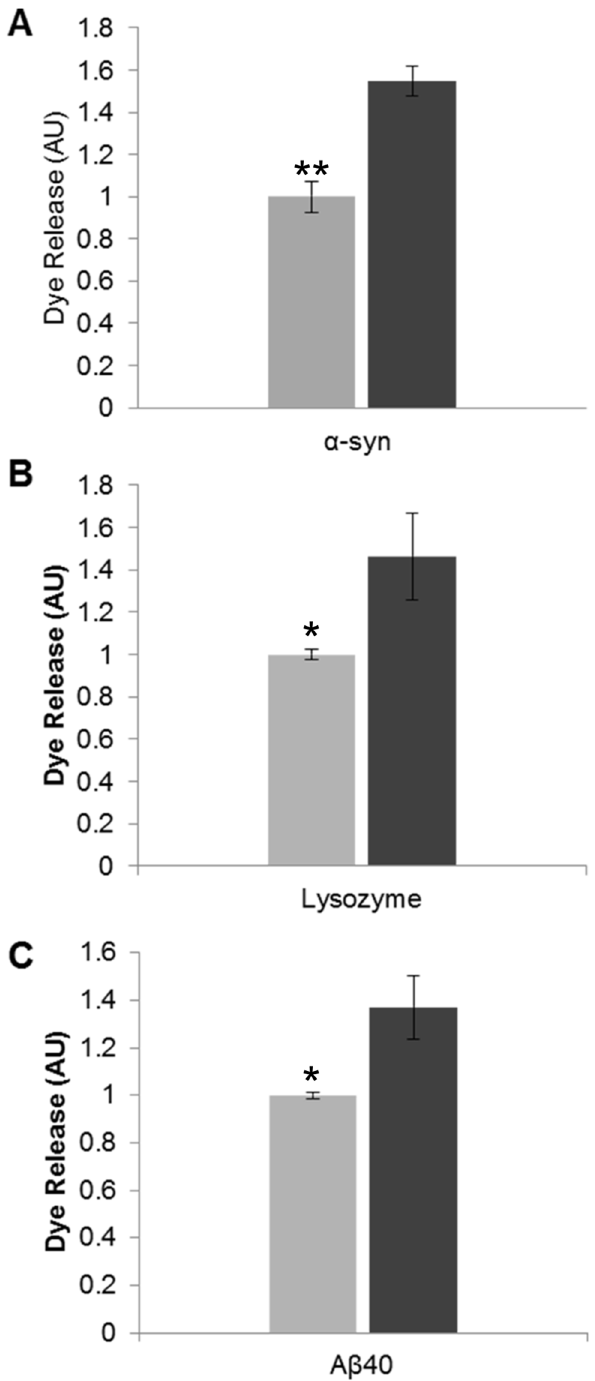
Fig 2. The effect of fibril fragmentation on length and its capacity to cause membrane disruption. Liposome dye release assay using a model lipid membrane formed from 80% (w/w) phosphatidylcholine and 20% (w/w) phosphatidylserine encapsulating the fluorescent probe carboxyfluorescein. Dye-encapsulated vesicles were incubated with amyloid fibril samples (30 min): (A) α -Syn 100 μ g/mL (B) Lysozyme 20 μ g/mL and (C) A β 40 20 μ g/mL. Fluorescence was then recorded and the fold increase in dye release was normalised against unfragmented fibril fluorescence. Light grey bars denote unfragmented fibril samples and dark grey bars denote fragmented fibril samples (n = 3, error bars show SE). Statistical significance between the unfragmented and fragmented fibril dye release response was determined by a Mann Whitney U test P (cid:1) 0.05 ( * ) or P (cid:1) 0.005 ( ** ).